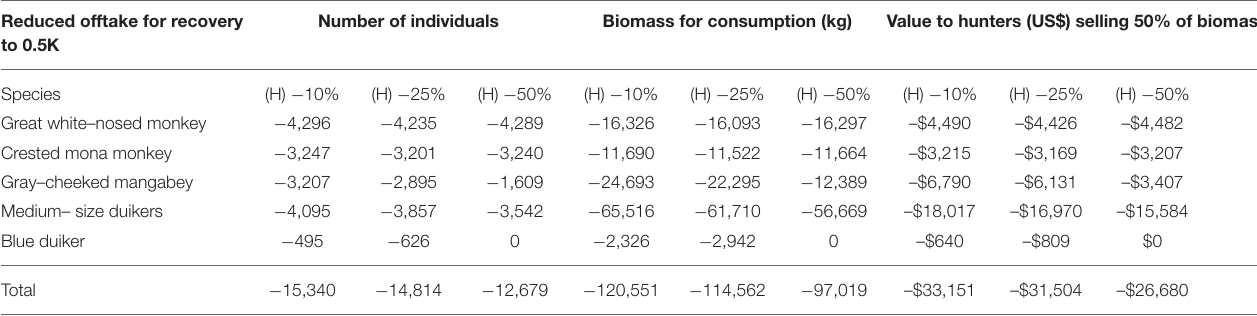
TABLE 3 | Reduction in: (a) animals hunted; (b) biomass available for consumption or sale; and, (c) economic value to hunters when hunting of depleted wildlife within 6km of villages is reduced by 10, 25, or 50% below sustainable yield ( H ) to allow populations to recover to 0.5K. Reduced offtake for recovery to